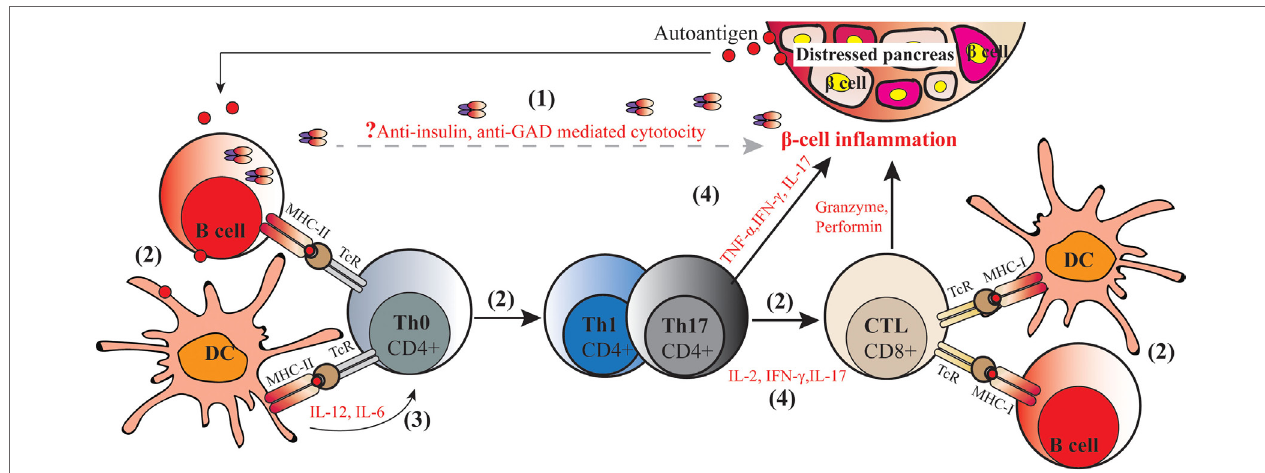
FiGURe 1 | Molecular pathogenic mechanisms of type 1 diabetes (T1D). The autoimmune process of T1D includes the following: (1) secretion of autoantibodies against islet proteins such as insulin and glutamic acid decarboxylase (GAD) by autoreactive B cells, which are viewed as markers but have not been assigned a direct pathogenic role on the development of diabetes; (2) autoantigens capture and (cross-) present to naïve CD4 + and CD8 + T cells by autoreactive antigen-presenting cells including macrophages, dendritic cells (DCs), and B cells through two signals, namely, presentation of autoantigens in MHC–peptide and activating co-stimulatory molecules, leading to induction of autoreactive helper CD4 + T cells, and cytotoxic CD8 + T cells; (3) production of (pro-)inflammatory cytokines by DCs that stimulate Th0 to convert into Th1 and Th17 cells; (4) secretion of inflammatory cytokines by Th1 and Th17 cells trigger CD8 + T cells to secret cytotoxic granzyme, perforin, nitric acid, peroxide, and other inflammatory cytokines. In this way, CD4 + T cells and CD8 + T cells act synergistically to kill islet β -cell in conjunction with β -cell autoantigens and MHC class I and class II antigens, resulting in the onset of autoimmune